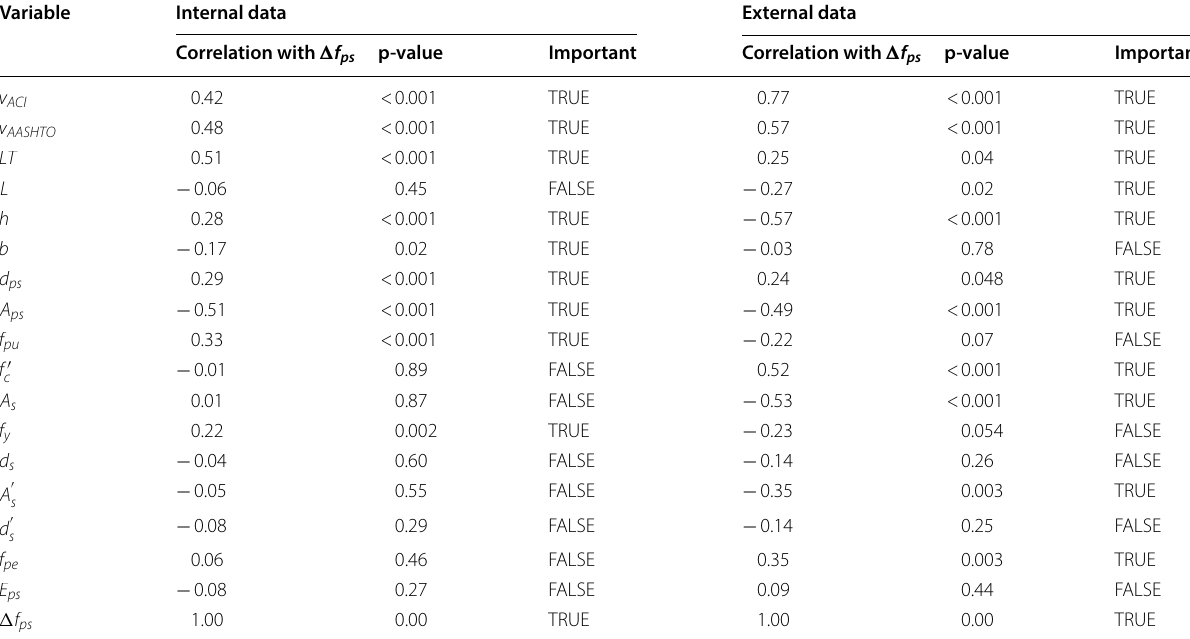
Table 3 Correlation Cutoff important variables for the internal and external data.